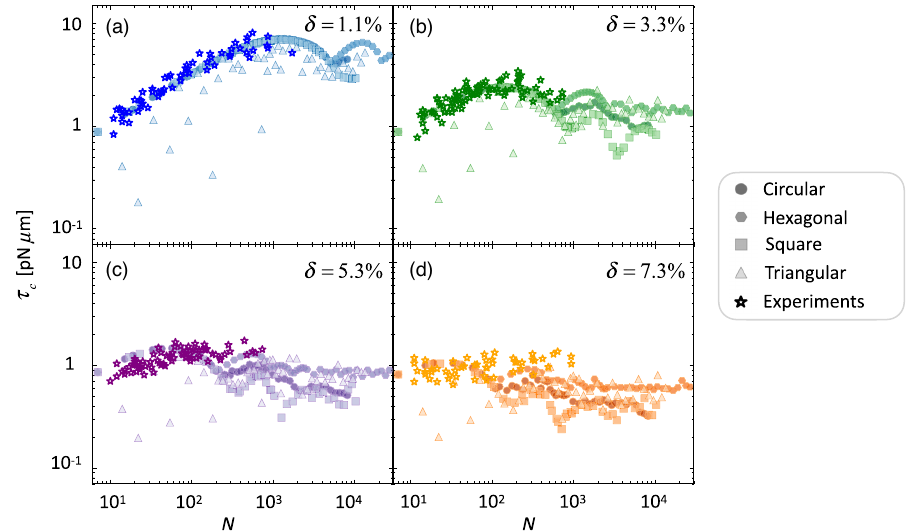
FIG. 6. The static torque τ as a function of cluster size N calculated numerically from the microscopic model for circular-, hexagonal-, c square-, and triangular-shaped clusters (filled data points) and measured from experiments for irregular-shaped clusters (empty stars). Panels (a) – (d) correspond to results of different lattice mismatches δ ¼ 1 . 1% , 3.3%, 5.3%, and 7.3%,